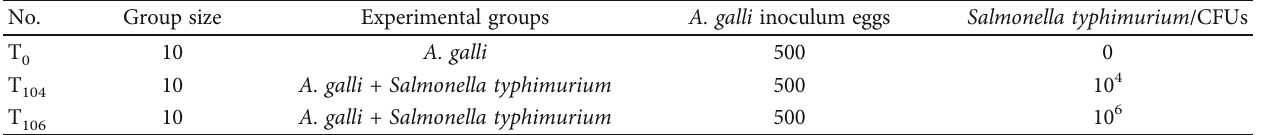
Table 1: Experimental design-1.